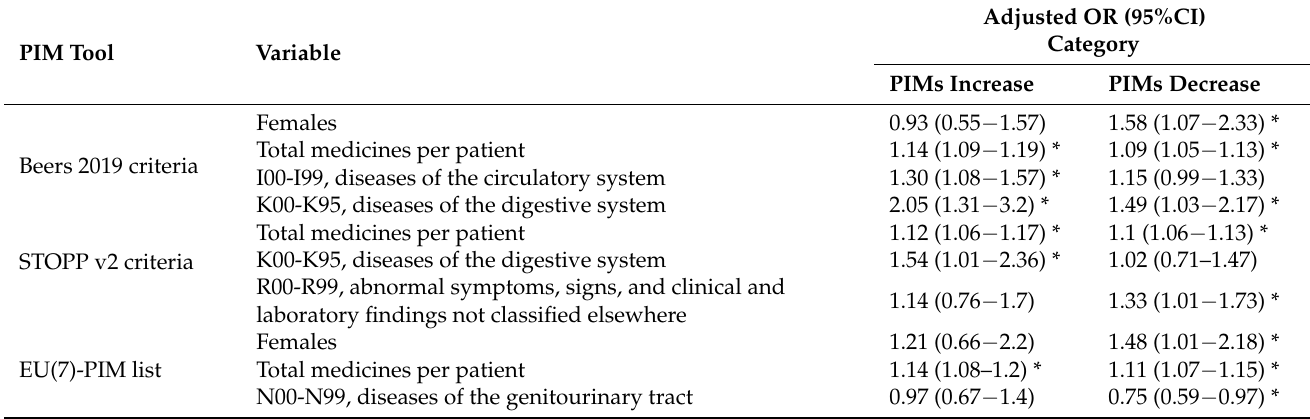
Table 4. Factors associated with categories of increased or decreased PIMs.